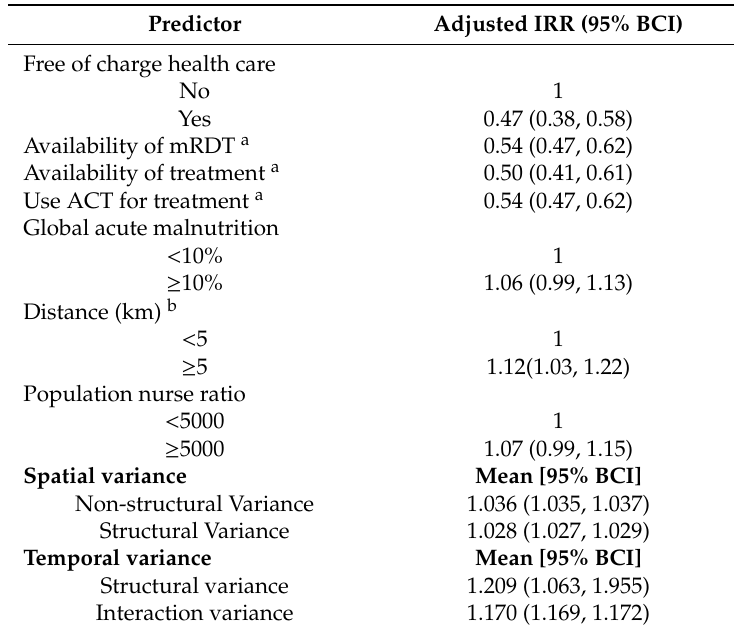
Table 1. Association of health programs with severe malaria case fatality rate estimated from the spatio-temporal model adjusted by contextual